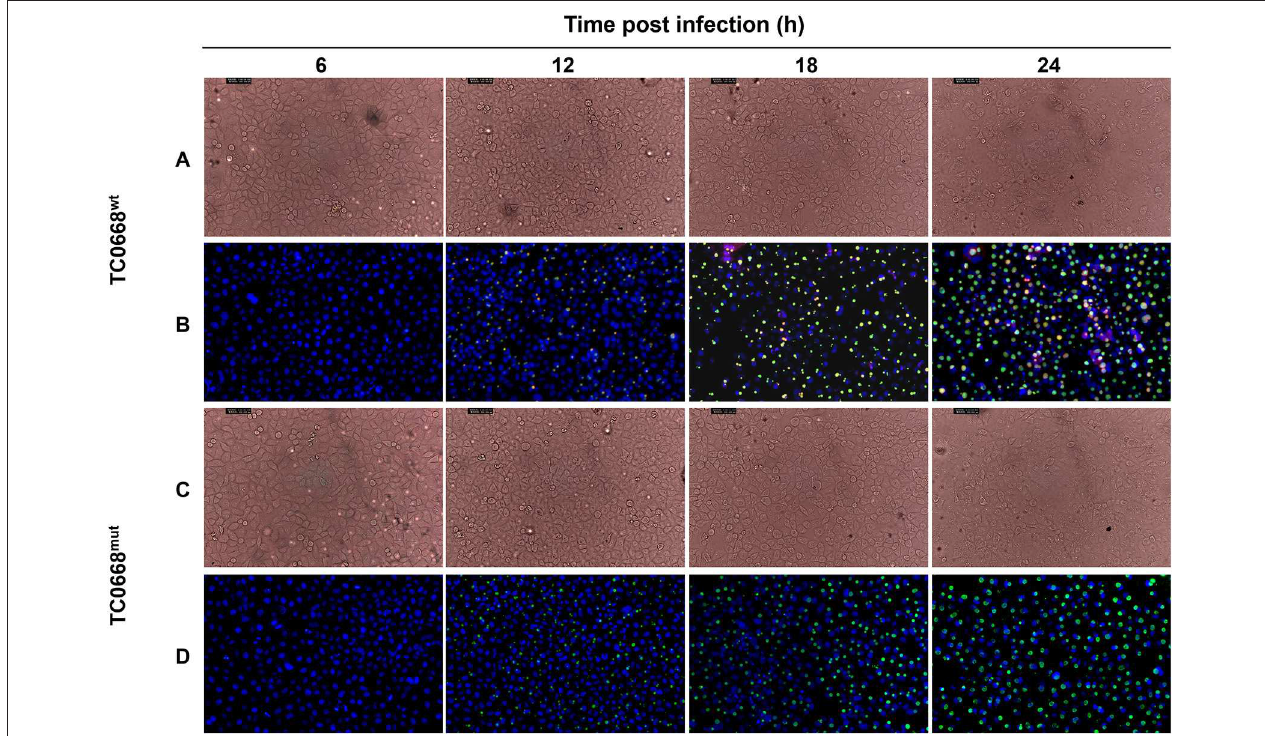
FIGURE 1 | Indirect immunofluorescence assay (IFA) of HeLa cells infected with C. muridarum TC0668 wt or TC0668 mut strains. With 2.5 × 10 5 IFU/well inoculum (MOI = 1), Chlamydia -infected HeLa cells were photographed using optical microscopy at 6, 12, 18, and 24h p.i. Chlamydial inclusion bodies (green) are visible in both TC0668 wt - and TC0668 mut -infected cells, whereas the TC0668 protein (red) is only visible in TC0668 wt -infected HeLa cells. Magnification, × 200. TC0668 wt -infected HeLa cells were photographed by using phase contrast microscopy (A) and IFA (B) at 6, 12, 18, and 24h p.i. TC0668 mut -infected HeLa cells were photographed by using phase contrast microscopy (C) and IFA (D) at 6, 12, 18, and 24h p.i.